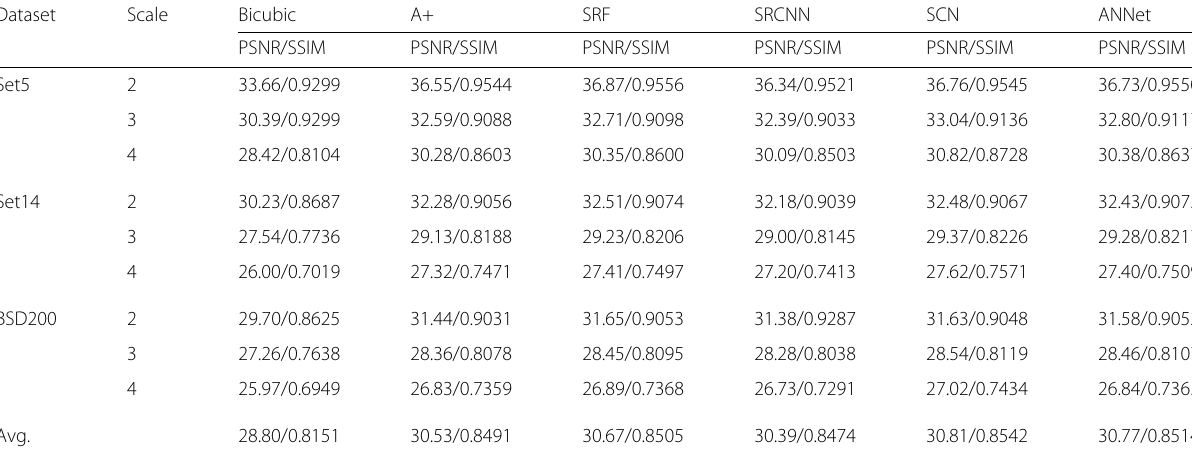
Table 4 The results of average PSNR (dB) and SSIM on the Set5 [1], Set14 [37], and BSD200 [23] Dataset Scale